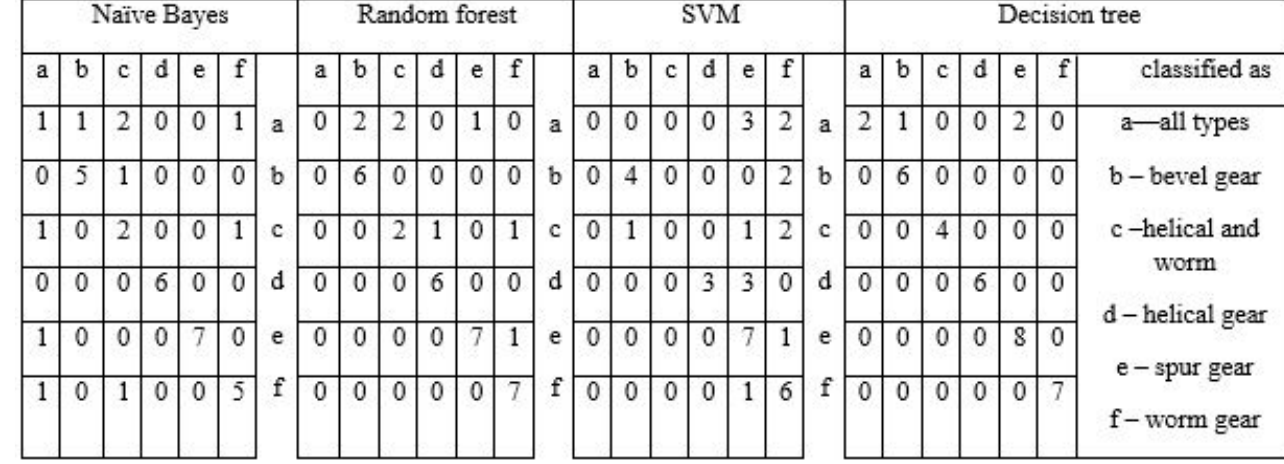
Figure 6. Screen shot of extracted enterprise information and classification into task-specific supplier with text mining.